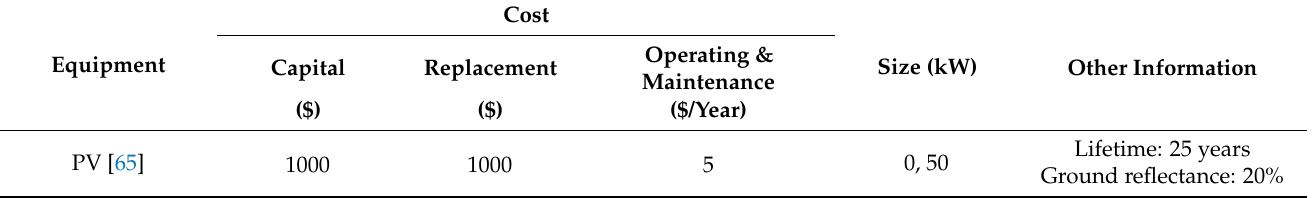
Table 3. Information of BIPV system under